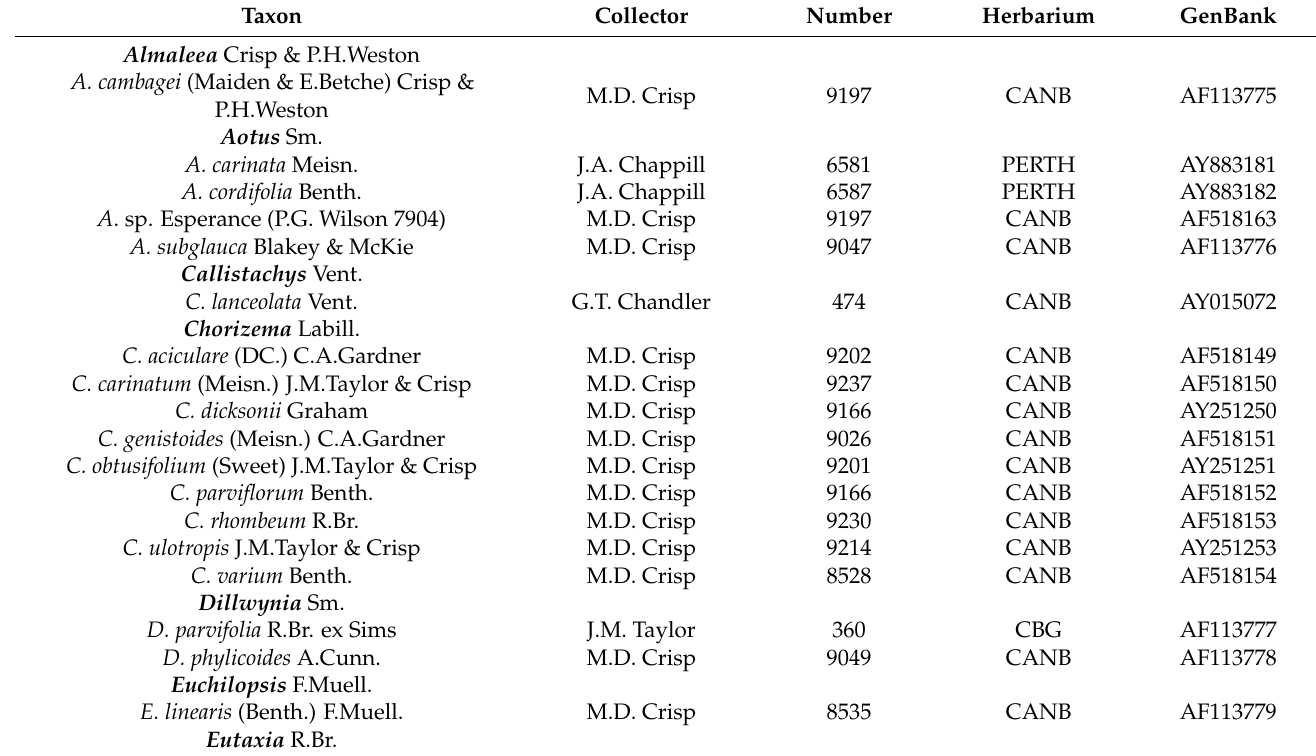
Table 2. Taxa analysed, vouchers and GenBank reference numbers for the trn L intron and trn L–F spacer. Herbarium codes for voucher location follow Thiers (2008 onwards; http://sweetgum.nybg.org/science/ih/ (accessed on 25 April 2021)). Taxon Collector Number Herbarium